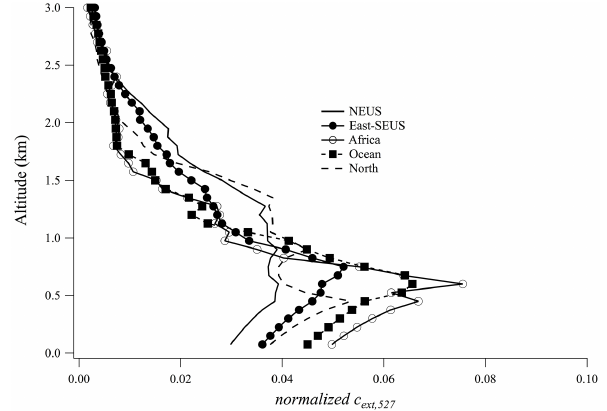
Figure 6. Normalized lidar profiles, averaged over flow regimes. The standard deviation is not shown in this figure, but was approxi- mately 0.02 for altitudes less than